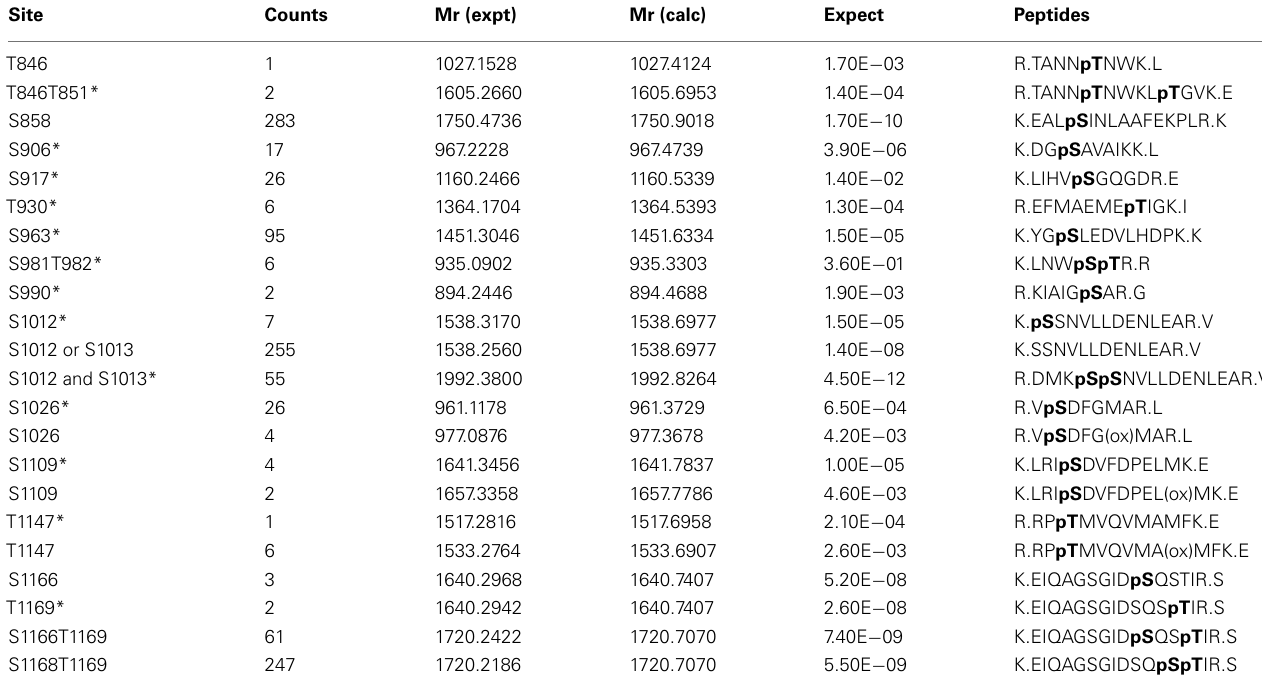
Table 1 | Identified autophosphorylation sites of Flag-BRI1 expressed in E. coli